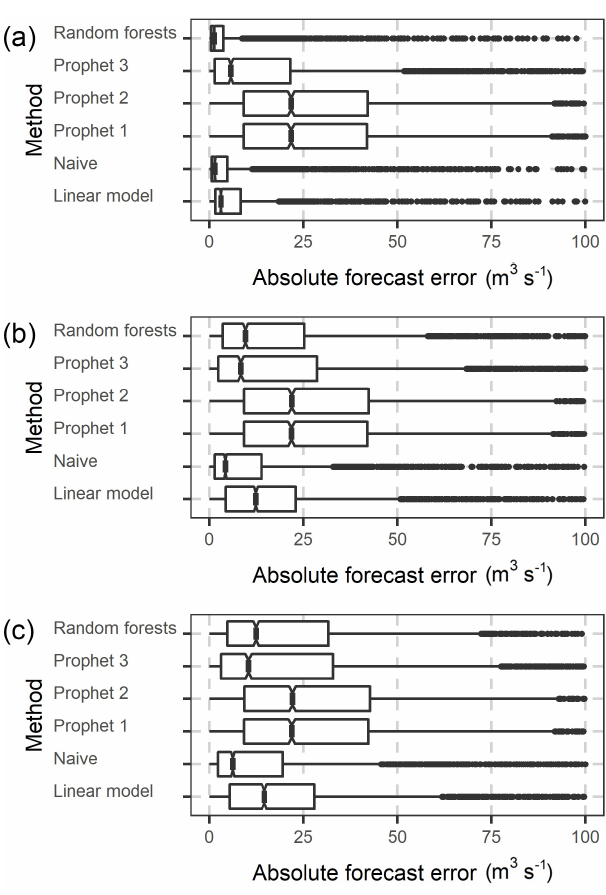
Figure 5. Notched boxplots of the absolute forecast errors of the 1, 4 and 7-step ahead forecasts ( a to c ) of the daily streamflow of Current river in the period 2004–2013. The x axis of the three graphs has been truncated at 100m 3 s − 1 .